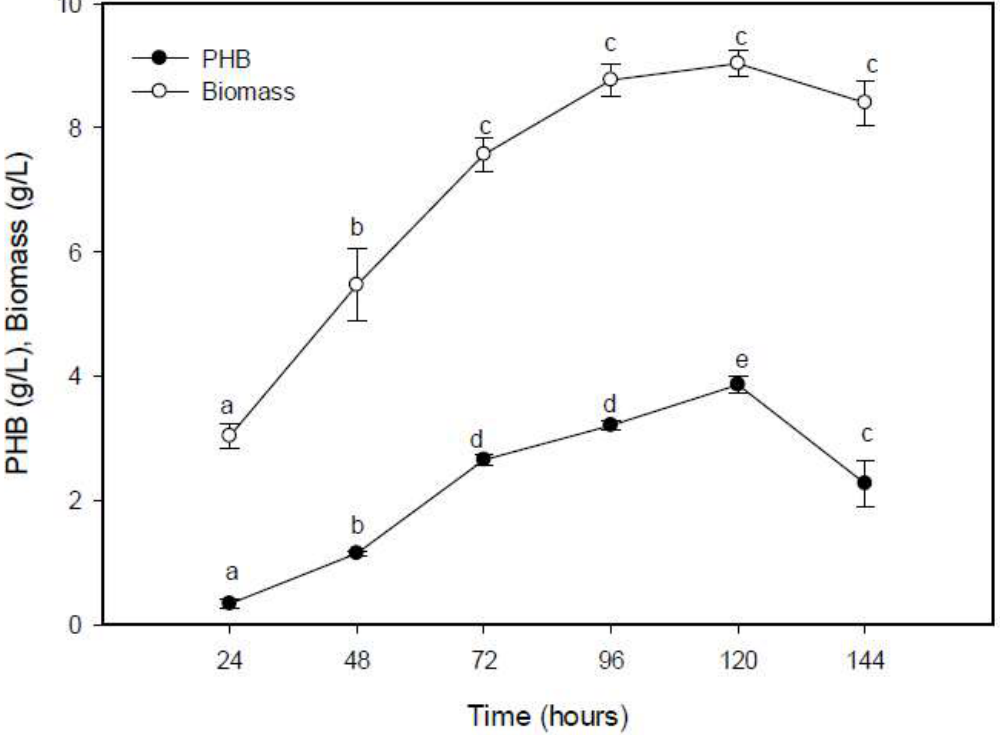
Figure 4. Effect of fermentation period on the PHB production by E. aquimaris . The values set by oneself letter(s) on the same line were not significantly different.